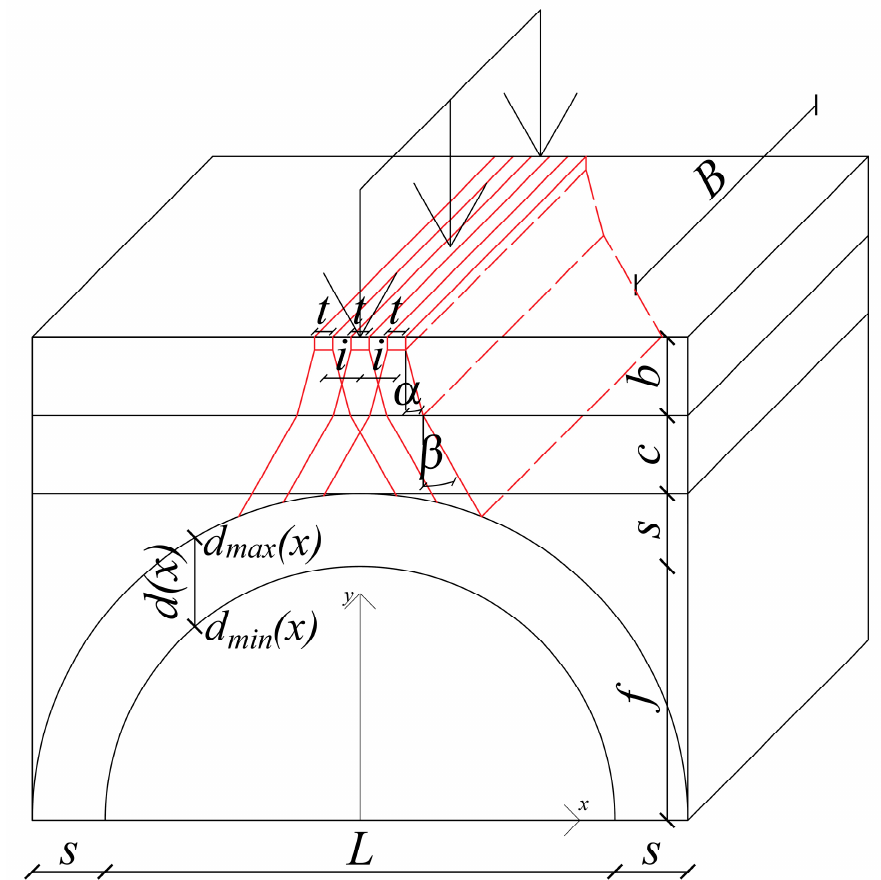
Figure 5. Load redistribution hypothesis.